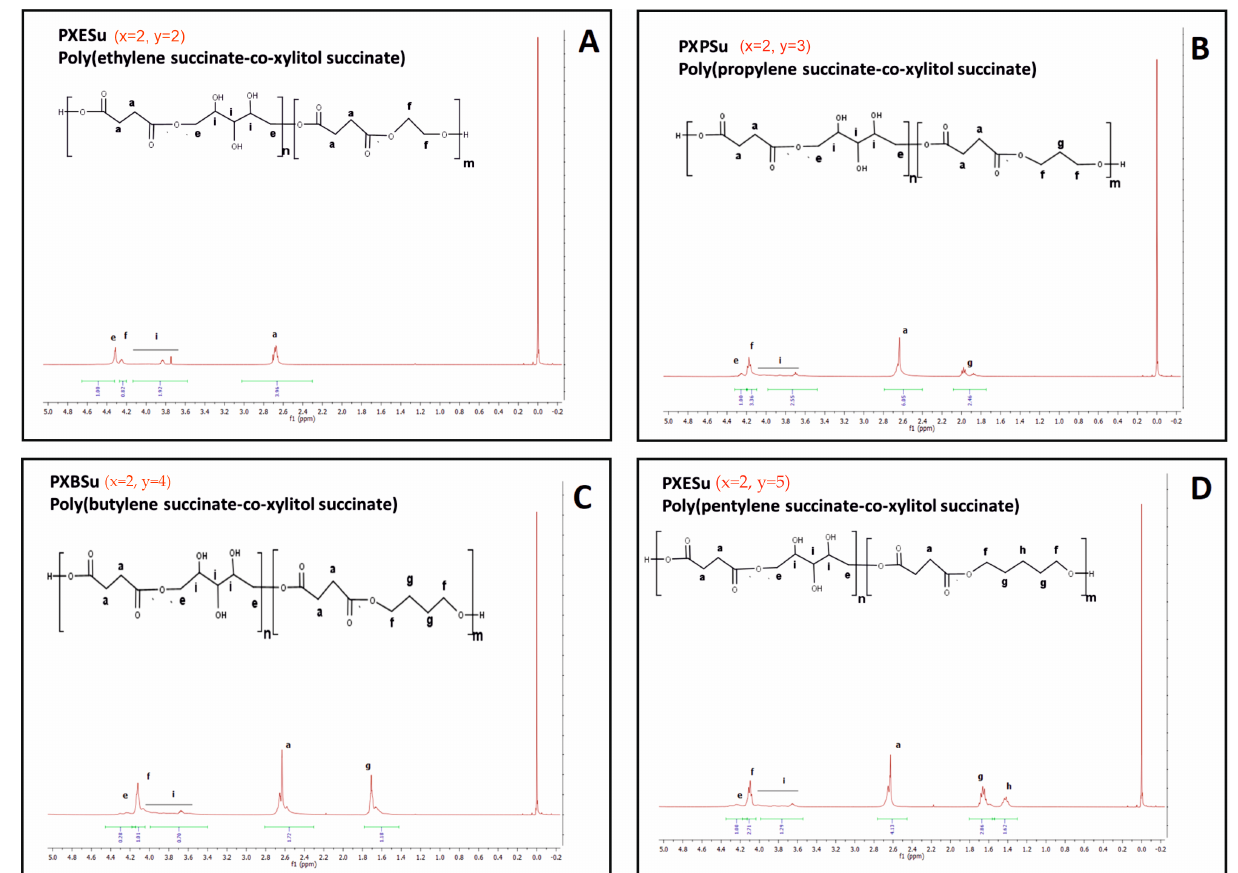
Figure 2. 1H NMR of PXESu ( A ), PXPSu ( B ), PXBSu ( C ), and PXPeSu ( D ) prepolymers. In 1 H NMR, peaks ranging from about 2.6 ppm to 1.2 ppm were attributed to − CH 2 groups in both diols and dicarboxylic acid peaks at about 1.4 ppm. This association was due to the CH 2 (h) group in diol with a peak at about 1.6–1.8 ppm, linked to the CH 2 (b) group in dicarboxylic acid and CH 2 (g) group in diol. The peak at about 2.4–2.6 ppm was associated with the CH 2 (a) group in the dicarboxylic acids. Peaks in the range of 3.6–4.6 ppm were associated with secondary − OH groups in xylitol. The peak at about 4.2 ppm